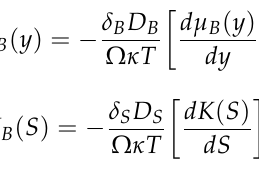
Figure 4. The geometry schematic of interface when the TiAl melt corrading the Nb container.